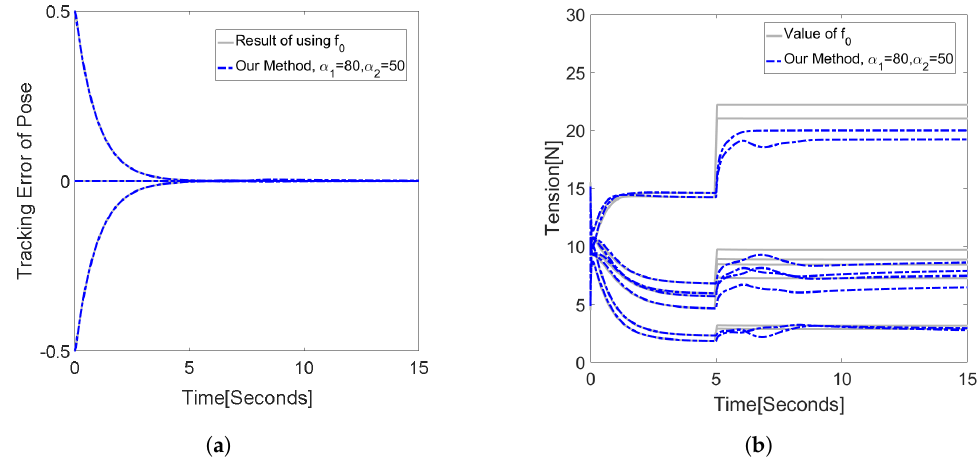
Figure 9. Force level changing with our method. Parameters and desired pose are selected as α 1 = 80, α 2 = 50, K d = 2, D d = 1, K i = 0, q d = [ 0.6, − 0.6,0.6,0,0,0 ] T , s = [ 10, . . . ,10 ] T ∈ R 8 ( 0 s → 5 s ) and s = [ 15, . . . ,15 ] T ∈ R 8 ( 5 s → 15 s ) . ( a ) Tracking error of pose. ( b ) Tension